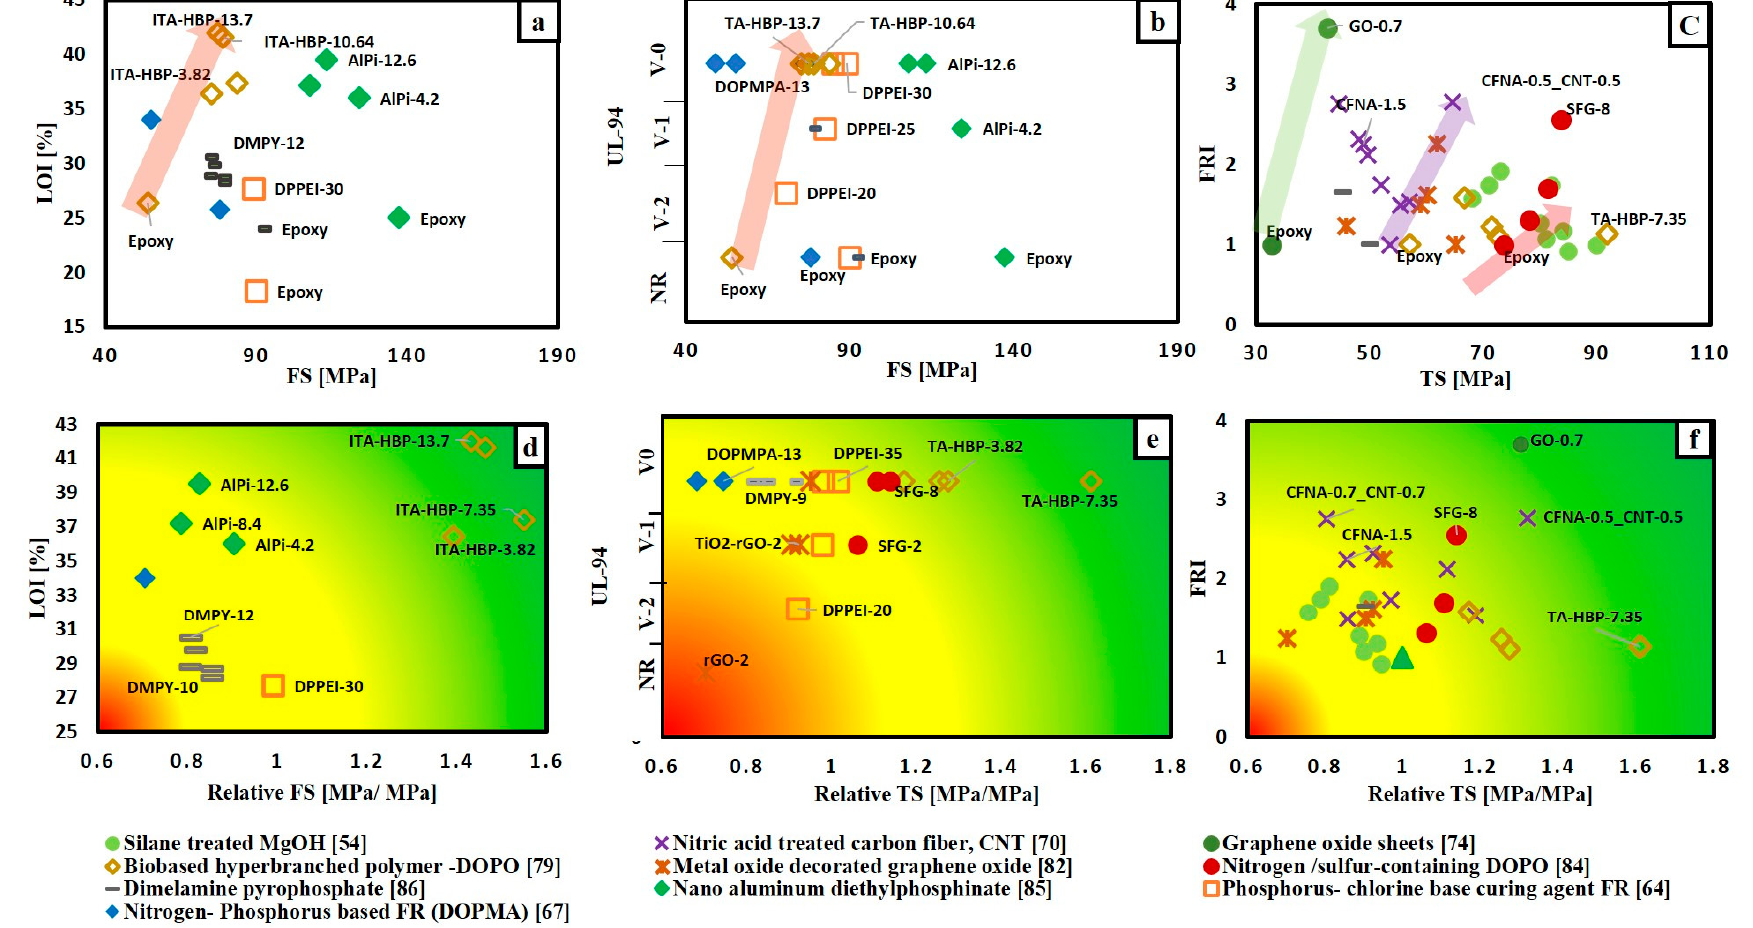
Figure 4. Selection chart of FR type regarding the desired flame retardance level and the mechanical property for epoxy resin. ( a ) LOI% versus FS; ( b ) UL-94 versus FS; ( c ) FRI versus TS; ( d ) LOI% versus relative FS; ( e ) UL-94 versus relative TS; ( f ) FRI versus relative TS.